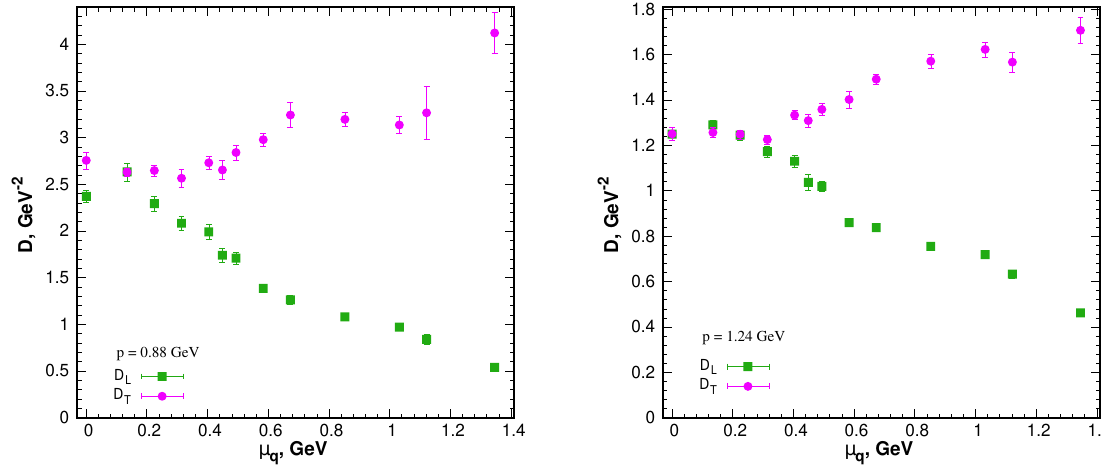
Figure 3. Gluon propagators as functions of µ q at the minimal and next-to-minimal